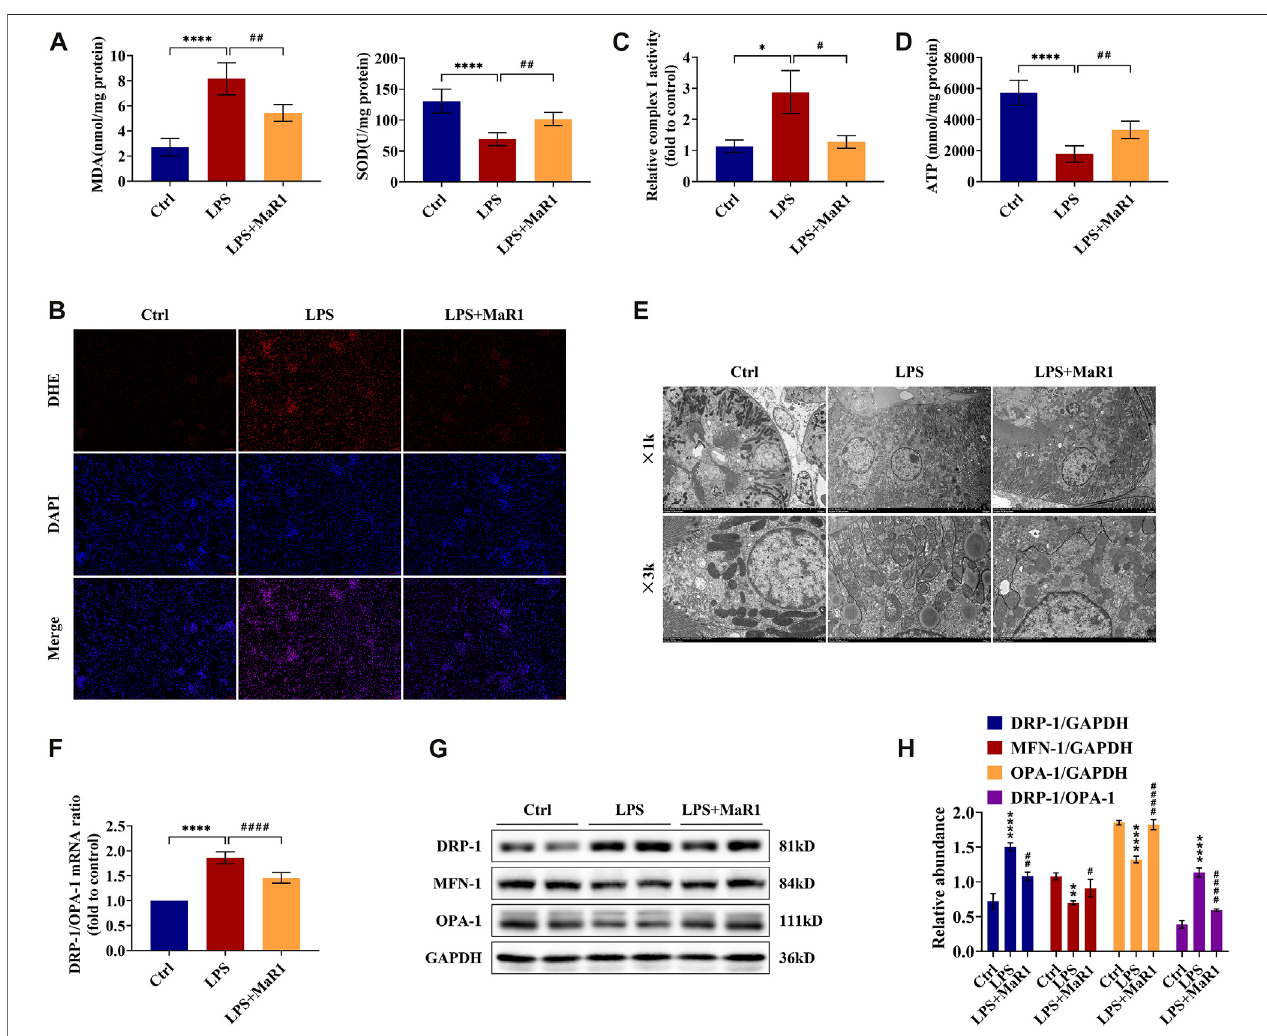
FIGURE3| MaR1 attenuated oxidativestressand protected mitochondrialquality inthekidneysoflipopolysaccharide (LPS)-induced S-AKImice. (A) Thelevelsof malondialdehydeandsuperoxide dismutaseofrenaltissuesineachgroupofmiceweredetected usingassaykits. (B) Reactiveoxygenspecieswereassessed insitu by staining (scale bar (cid:2) 50 μ m). (C) The relative complex I activity of renal tissues in each group of mice was evaluated using assay kits. (D) The ATP production of renal tissues was detected using assay kits. (E) Photomicrographs were collected by transmission electron microscopy (1k and 3k). (F) The gene expression ratio of DRP-1/OPA-1inrenaltissueswasquantitatedusingqRT-PCR. (G) TheexpressionsofDRP-1,MFN-1,andOPA-1inrenaltissueswereanalyzedusingWesternblot. (H) The protein levels of DRP-1, MFN-1, and OPA-1 were quanti fi ed by densitometry and normalized with GAPDH (time point: 12 h). Data are presented as mean ± SD, n (cid:2) 5. * p < 0.05, ** p < 0.01, *** p < 0.001, **** p < 0.0001 vs Control group; # p < 0.05, ## p < 0.01, ### p < 0.001, #### p < 0.0001 vs LPS